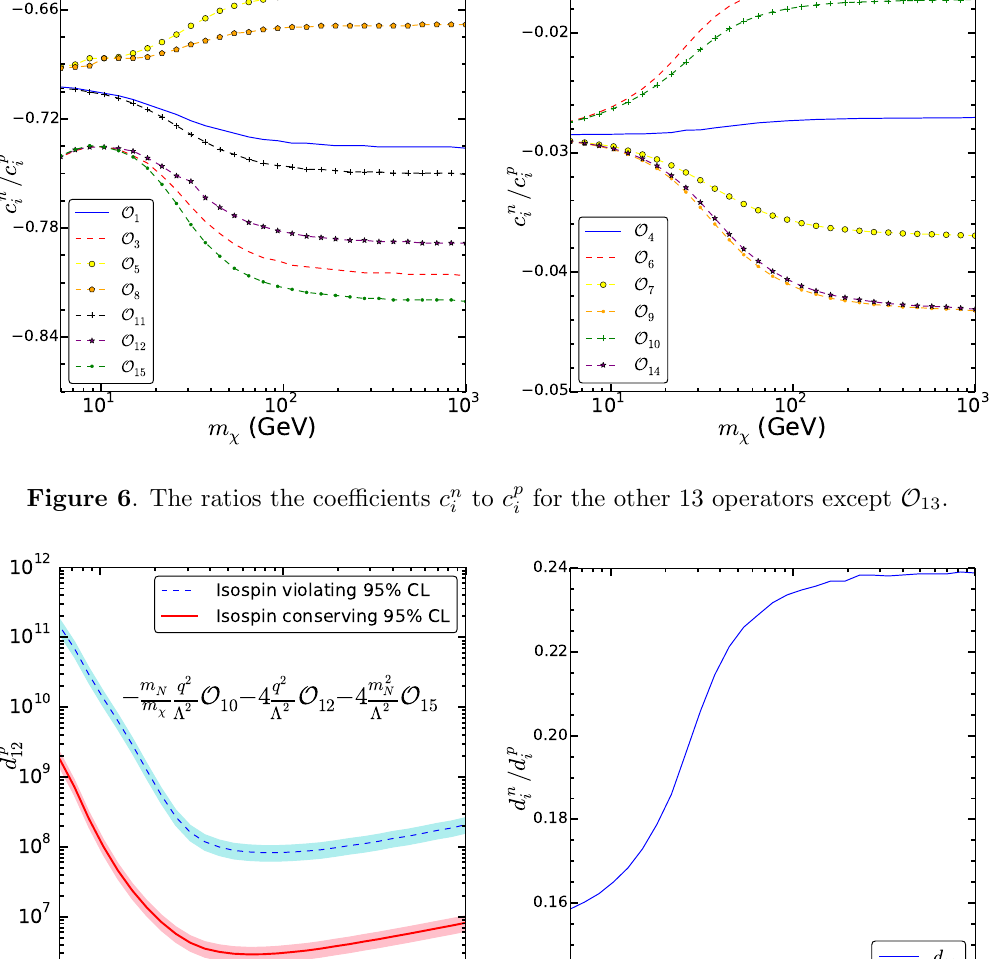
Figure 7 . Left panel: the 95% CL upper limits of the ISC (red solid) and ISV (blue dashed) cases for the coupling d p . The color bands demonstrate the uncertainties of the local DM density 12 measurements [53]. Right panel: the maximum cancellation ratio as a function of m (cid:31) for L 12